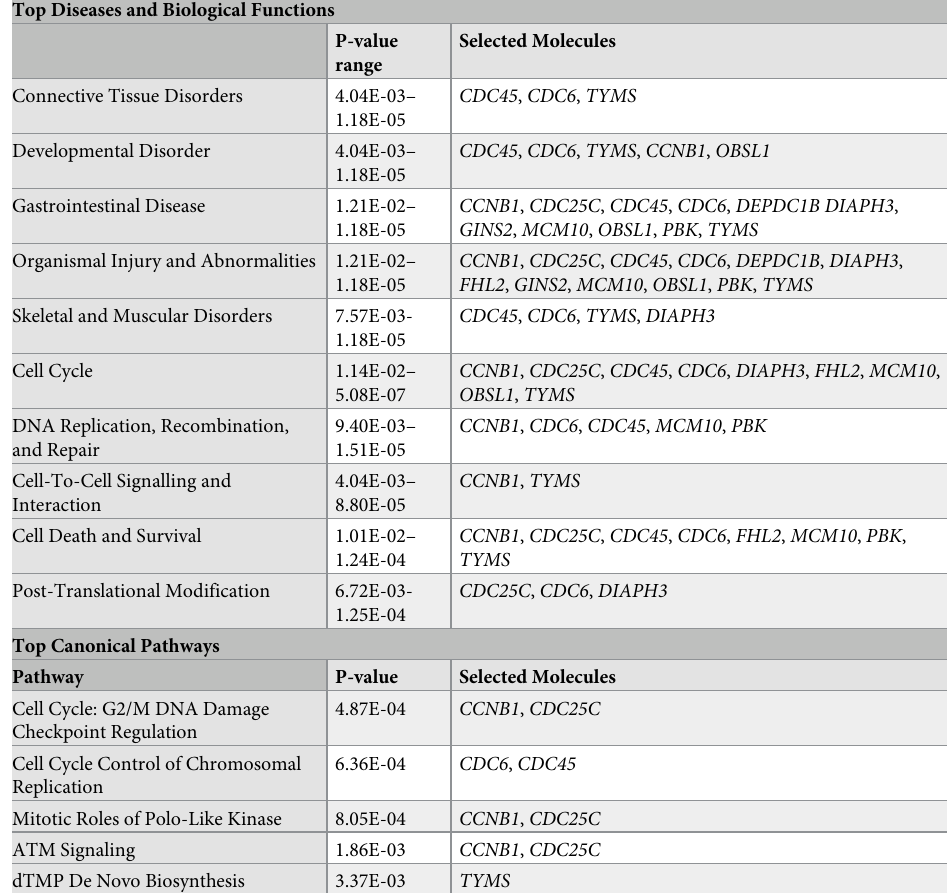
Table 1. Enrichment analysis of genes associated with COVID-19